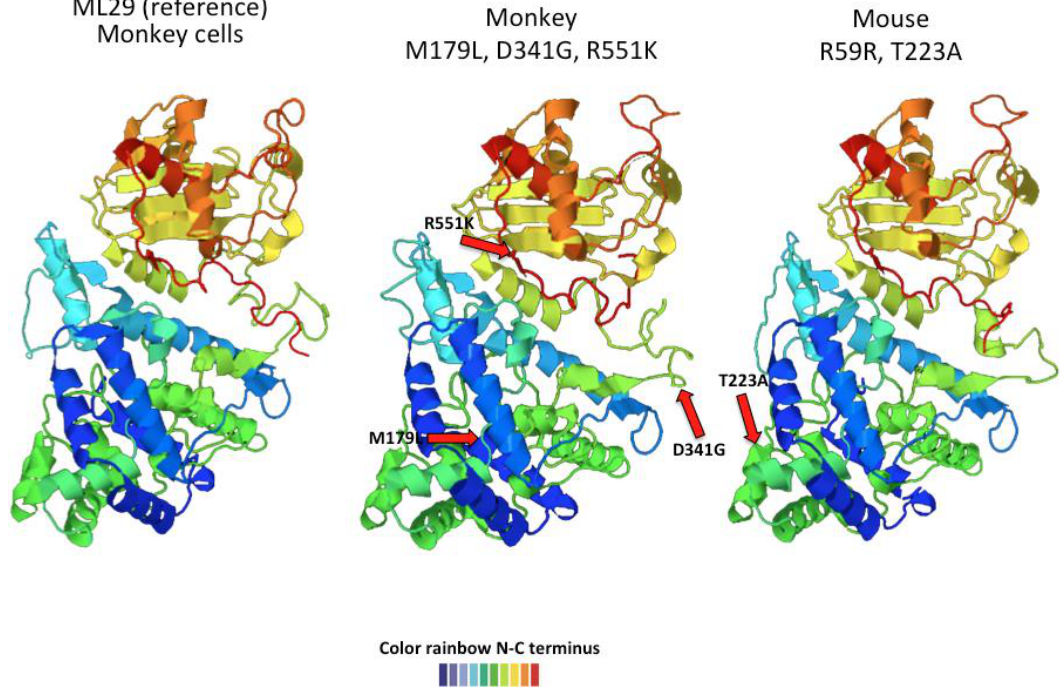
Figure 5. Predicted ML29 host-specific changes in NP. The left-most structure shows the ML29 NP predicted structure after passage in Vero cells. The middle structure represents the predicted NP changes (M179L, D341G, R551K) occurring in virus recovered from rhesus macaques only. The structure on the left shows two changes (R59R, and T223A) seen in mouse and marmosets. All host-specific mutations induced conformational changes in the NP predicted structure. The structure goes from N-terminus (blue) to C-terminus